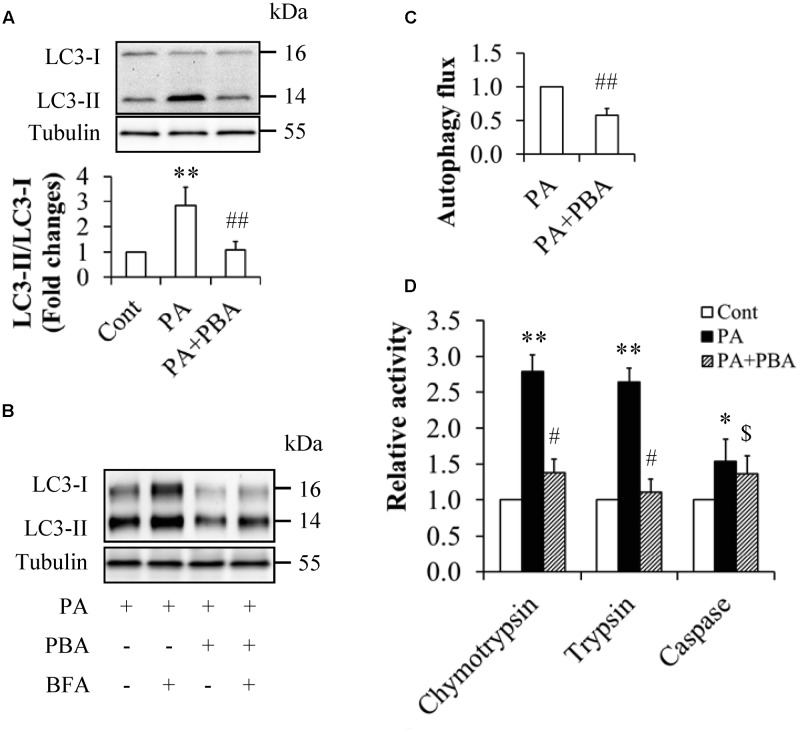
Inhibition of ER stress mitigated palmitate’s impacts on autophagy and the UPS in HUVECs. (A,B) Reduction of LC3 levels by ER stress inhibitor 4-phenylbutyrate (PBA). (C) Attenuation of autophagy flux by PBA. (D) Suppression of peptidase activities of 20S proteasome by PBA. N = 4. ∗p < 0.05, ∗∗p < 0.01 vs. control group; #p < 0.05, ##p < 0.01, $p > 0.05 vs. PA-treated group.